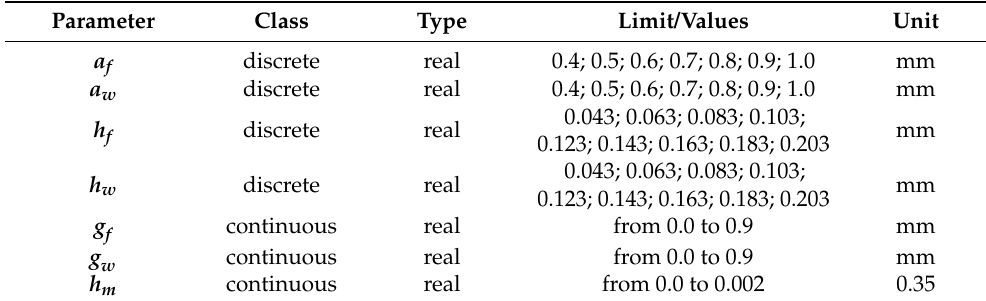
Table 2. Geometrical parameters related to repetitive unit cell to be optimized.